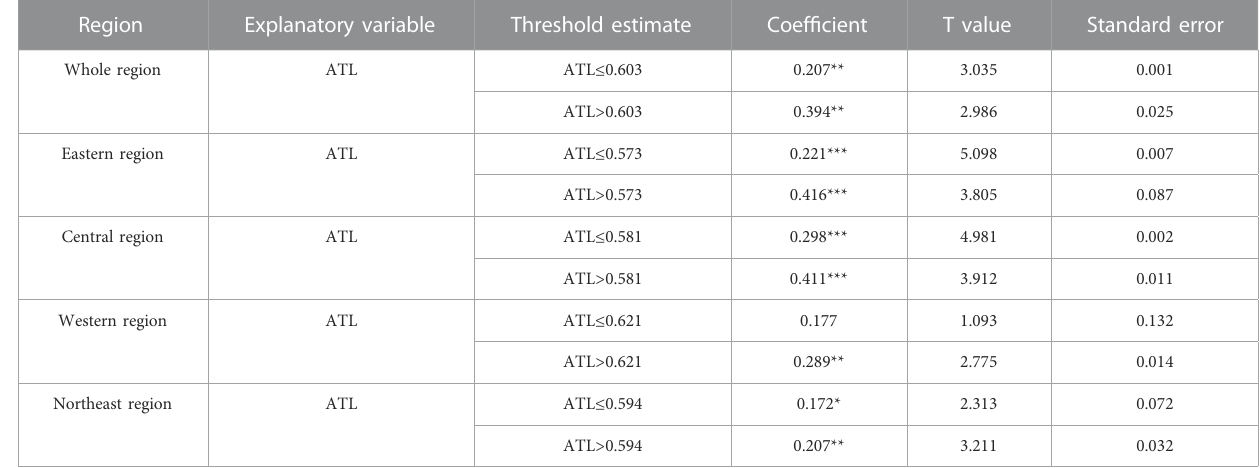
TABLE 13 Threshold effect estimation